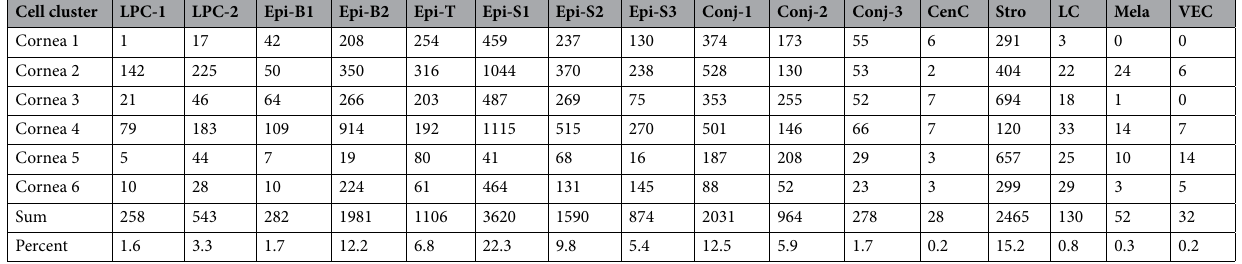
Table 1. Cell numbers contributing to each cell cluster from each donor